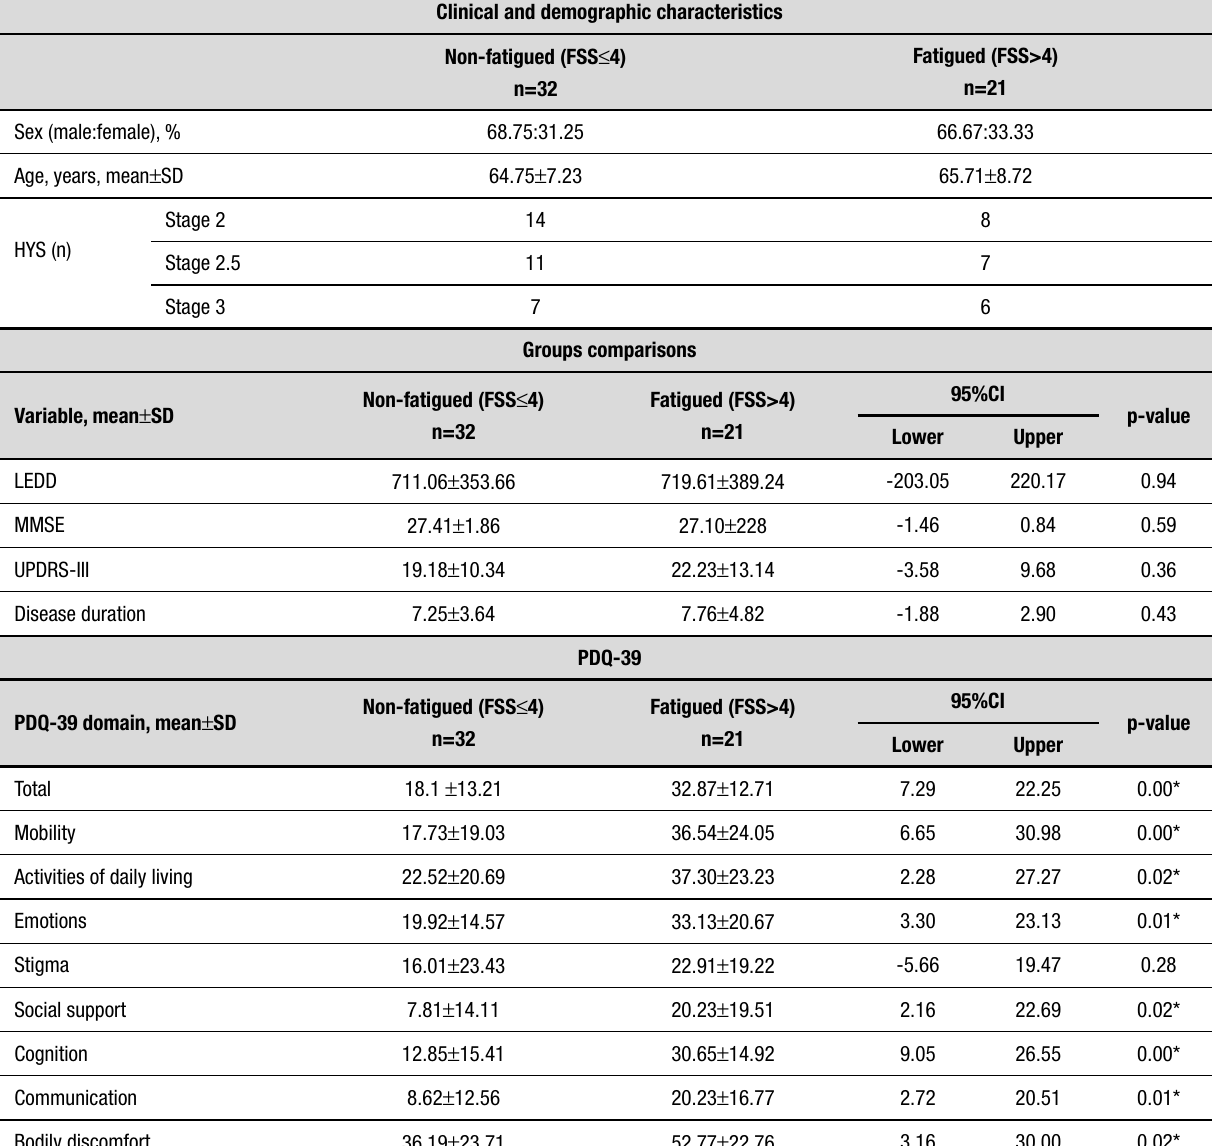
Table 1. Clinical and demographic characteristics and Parkinson Disease Questionnaire-39 comparisons between groups. Clinical and demographic